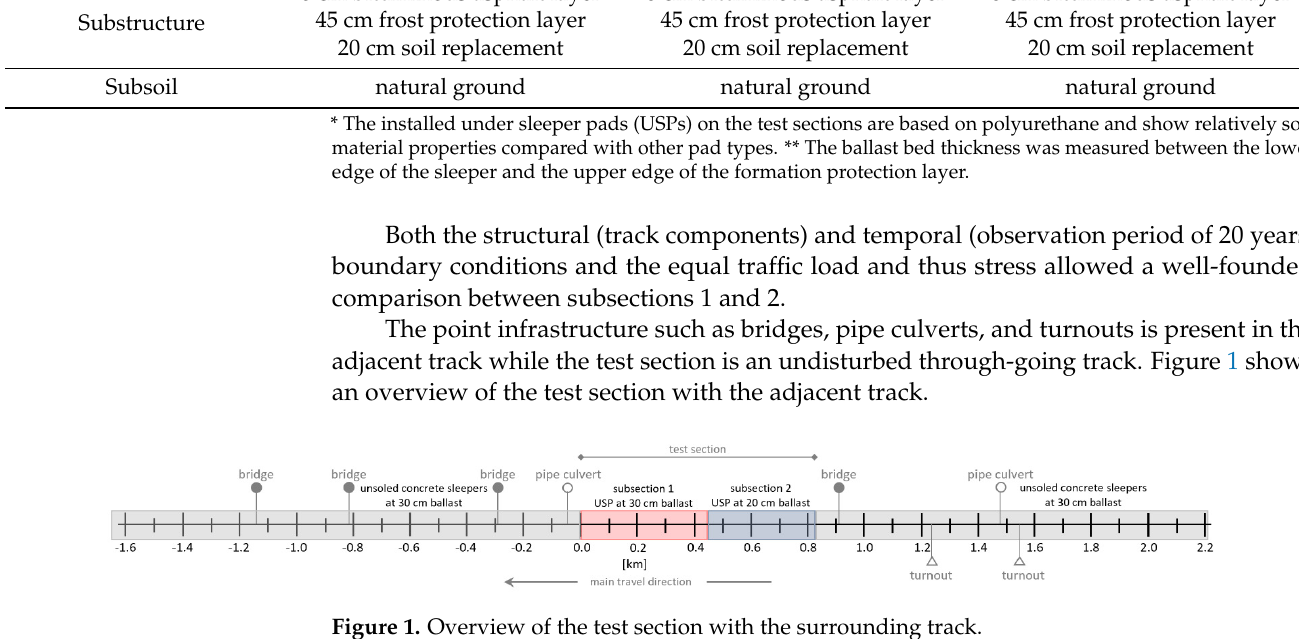
Figure 1. Overview of the test section with the surrounding track.